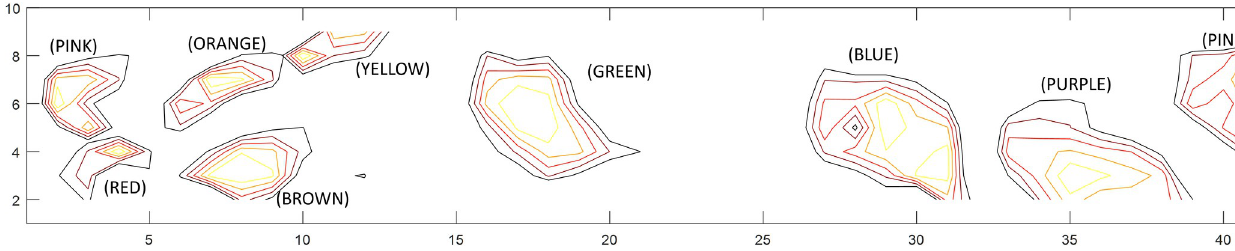
Fig 13. The pooled frequency distribution of the synonyms for color categories on the WCS